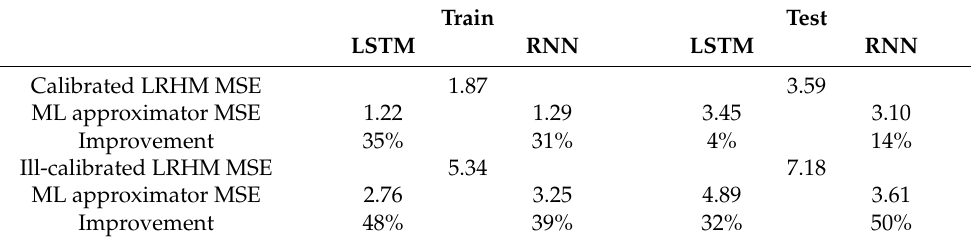
Table 1. Percentage improvement of the performance of the ML approximator over the calibrated and ill-calibrated LRHM hydrological model in the Bakas case study. Train Test LSTM